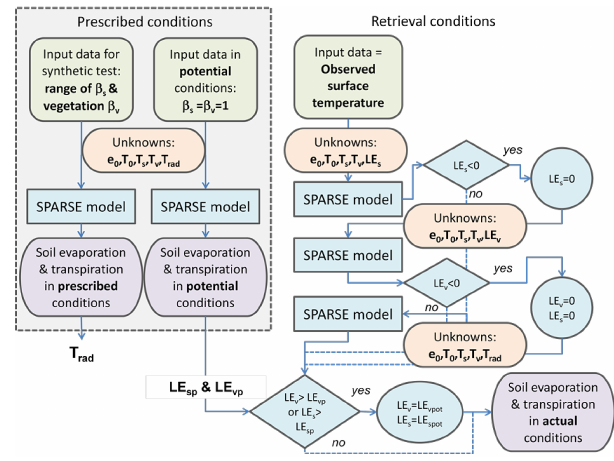
Figure 2. Flowchart of the SPARSE algorithm in prescribed and retrieval